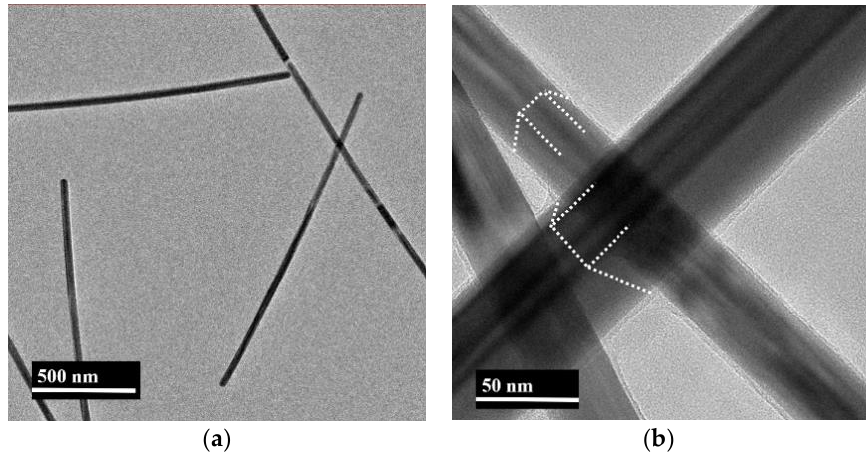
Figure 4. Transmission electron microscope (TEM) images of AgNWs at ( a ) 10k times and ( b ) 100k times magnifications.